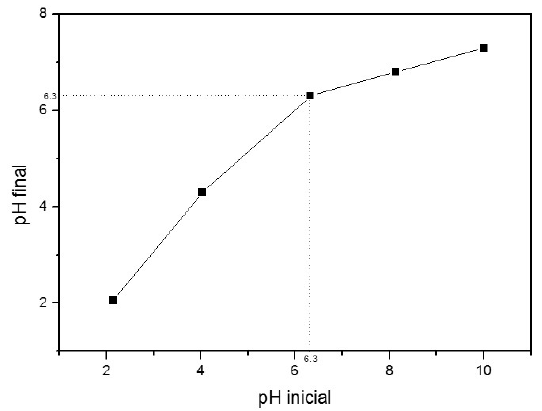
Figure 5. Determination of the point of zero charge of the Fe 3 O 4 @SiO 2 .